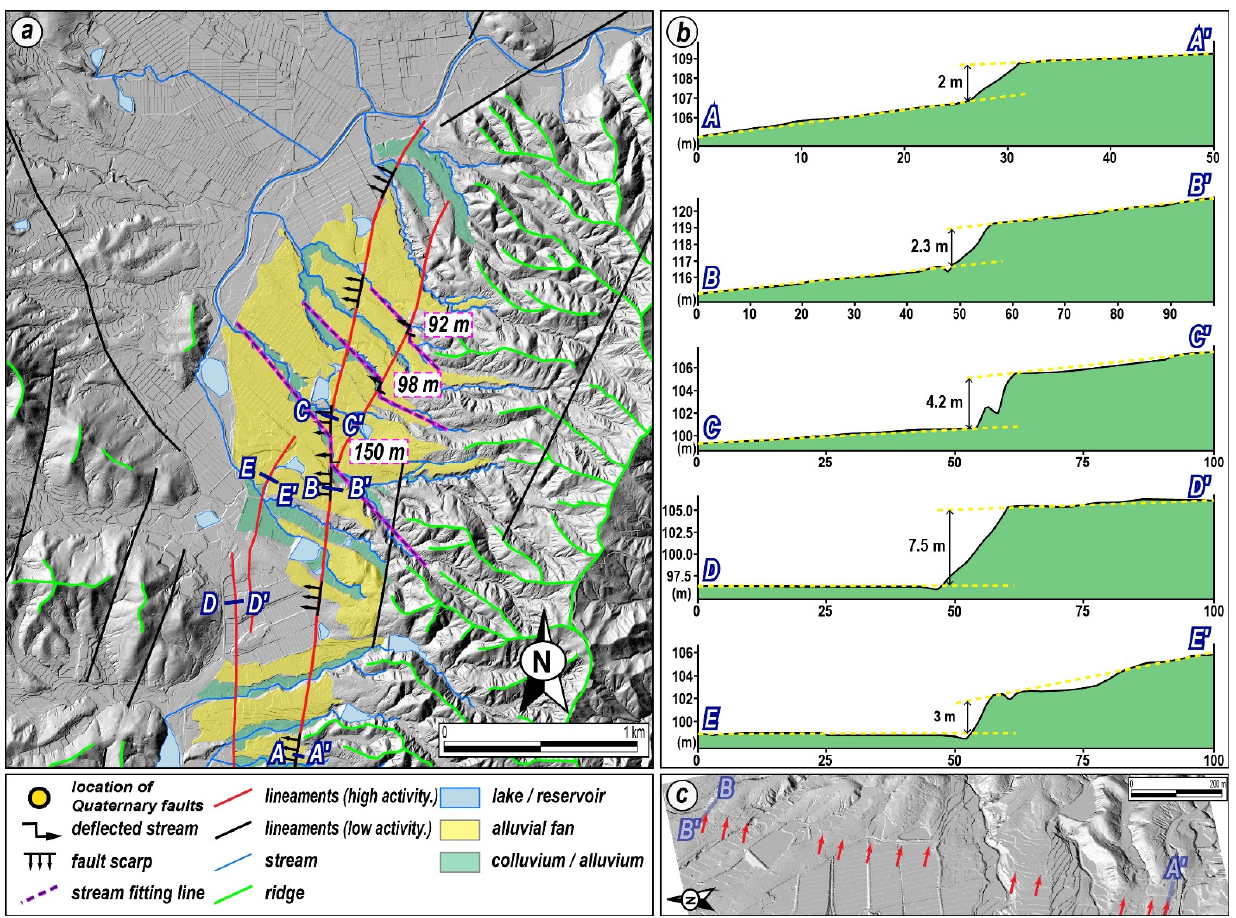
Figure 7. ( a ) Detailed topographic map of the northern area. An NNE lineament branching from the main lineament is indicated by the dextrally deflected stream. ( b ) Topographic profiles of the line (blue line in ( a )) across the fault scarps. Fault scarps in the northern section are evident based on the surface elevation difference in the similar landform. ( c ) Hillshade image 3D view. Red arrows indicate the fault scarp.